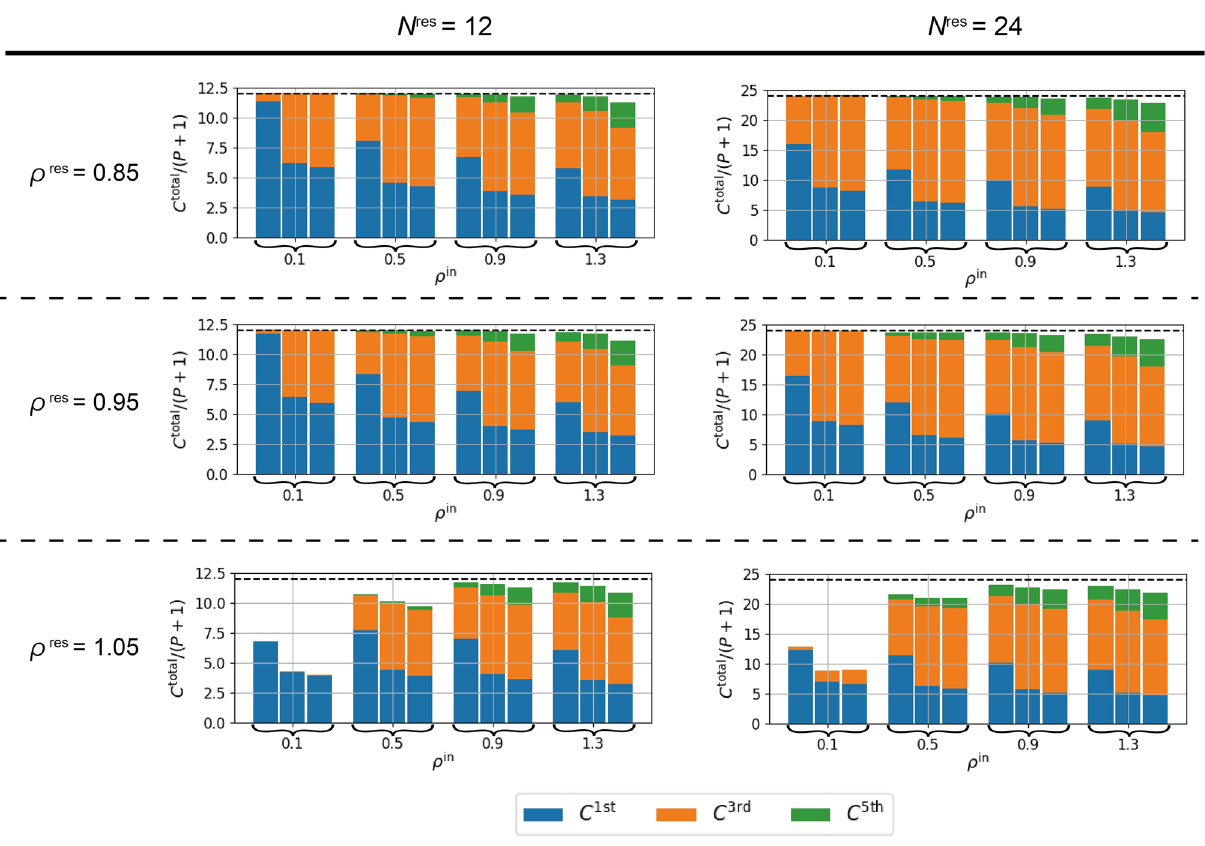
Figure 4. Analysis of IPCs. IPCs of standard RC and RC with the proposed methods for various values of input weight strength ρ in and spectral radius ρ res . The left and right panels show the results for N res = 12 and N res = 24 , respectively. The dashed horizontal line within each subgraph represents the value of N res . For each value of ρ in , the left column presents the standard RC with P = 0 , the center column presents delay-state concatenation with P = Q = 1 , and the right column presents drift-state concatenation with P = 1 .